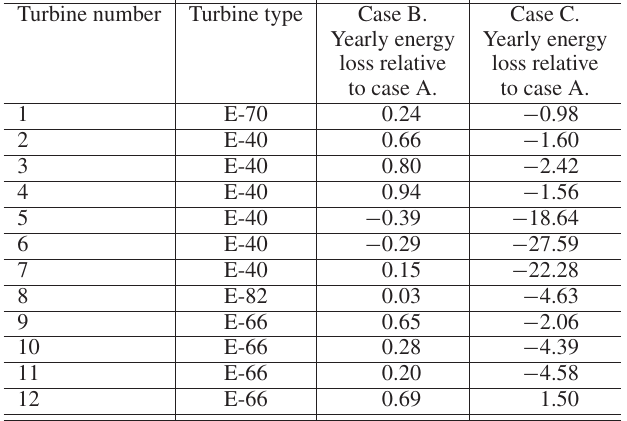
Table 3. Comparison of the relative change in the estimated annual energy yield, for each wind turbine and wind direction. Turbine